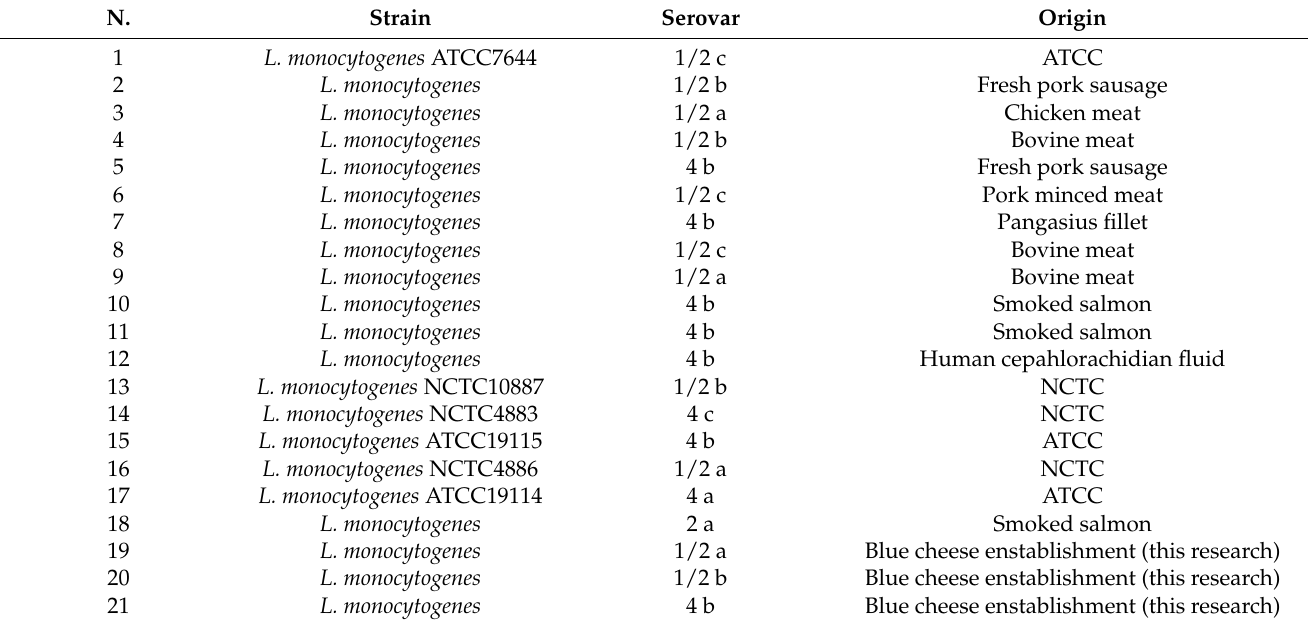
Table 1. Listeria monocytogenes strains utilized as hosts for Φ IZSAM-1 isolation and host range analysis (updated table from Aprea et al., 2018) [12].